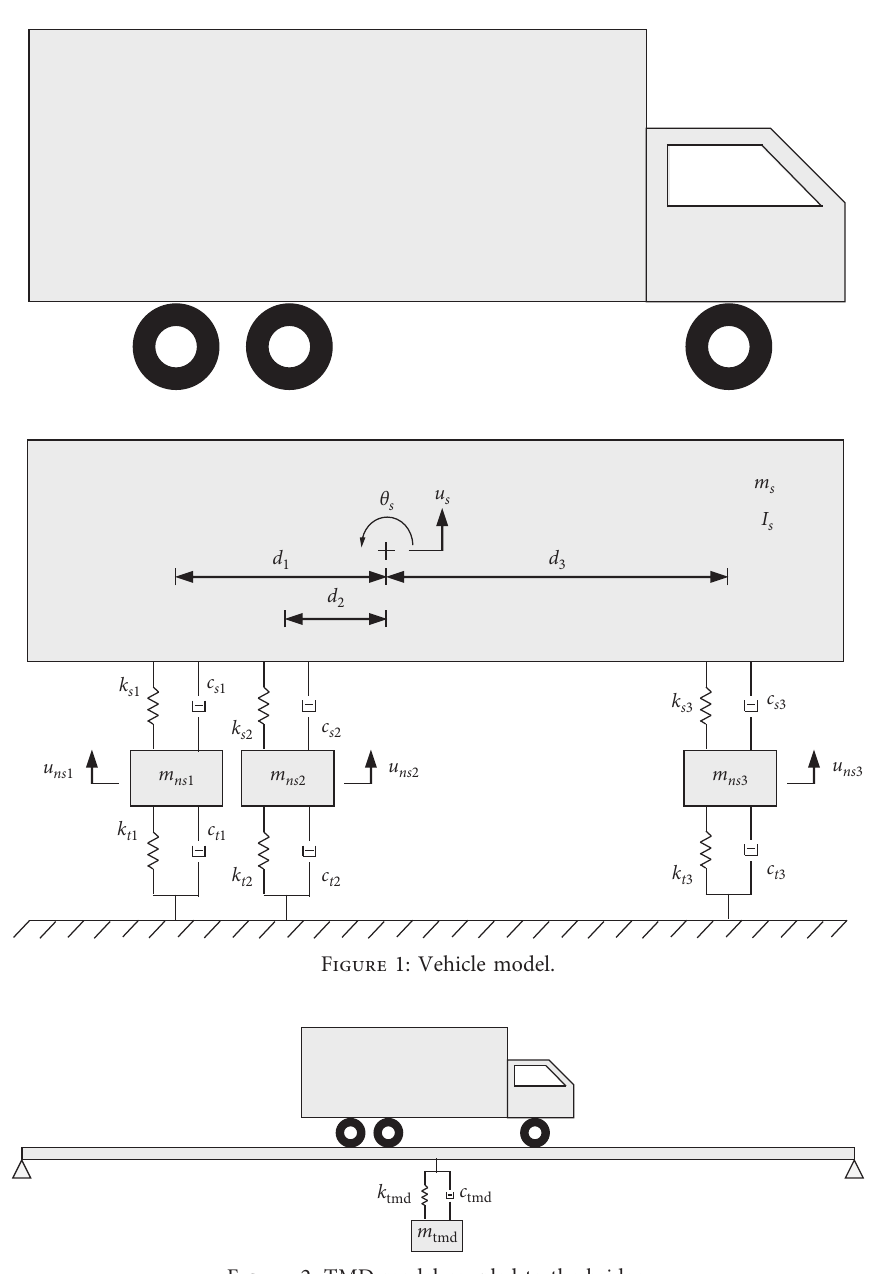
Figure 2: TMD model coupled to the bridge.